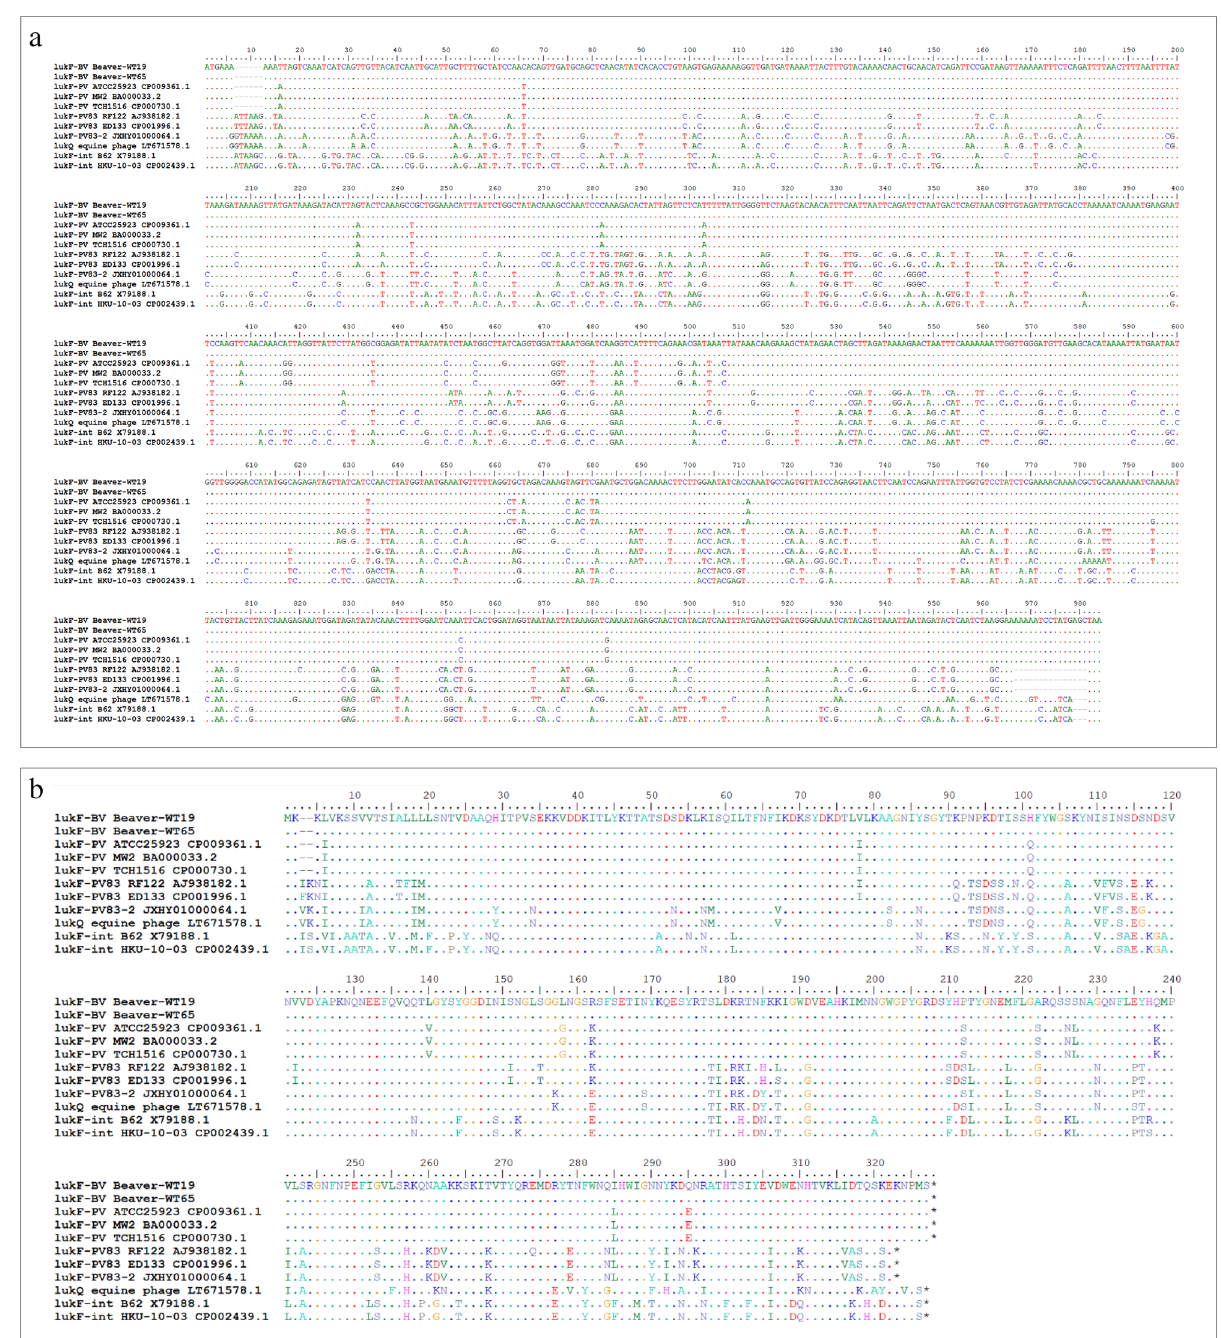
Figure 2. ( a ) Alignment of the lukF- BV sequences, of other phage-borne leukocidin F component sequences from S. aureus and of lukF -int from S. intermedius/pseudintermedius . ( b ) Alignment of the amino acid sequences of the corresponding lukF gene